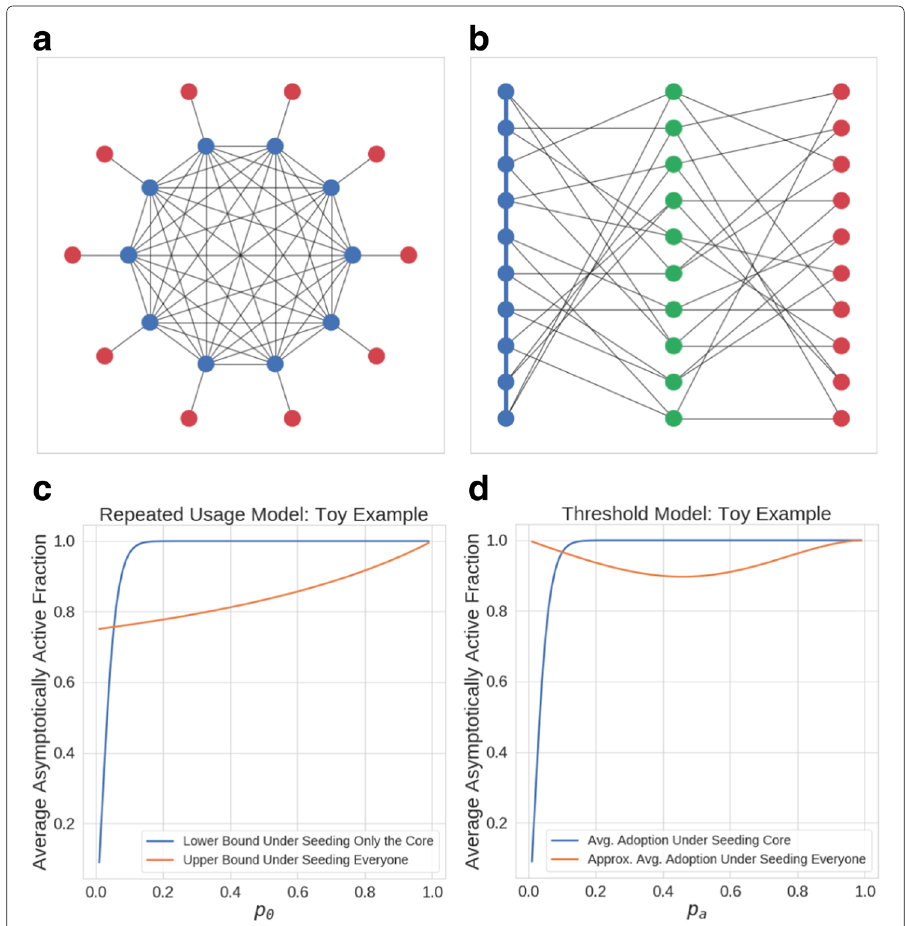
Fig. 1 a An example of the type of network used in the toy-example calculation for the repeated-usage model, with a complete N -graph for the “core” and N people in the periphery. b An example of the type of network used in the toy-example calculation for the threshold model, with N people each in core, intermediate, and periphery layers. The dark blue line connecting the core indicates that it is a complete N -graph. c Bounds on asymptotic adoption fractions under two seeding strategies in the repeated-usage model. Computations are for a network of the type shown in panel a, but with N = 50. d Average steady-state adoption fractions under two seeding strategies in the threshold model. Computations are for